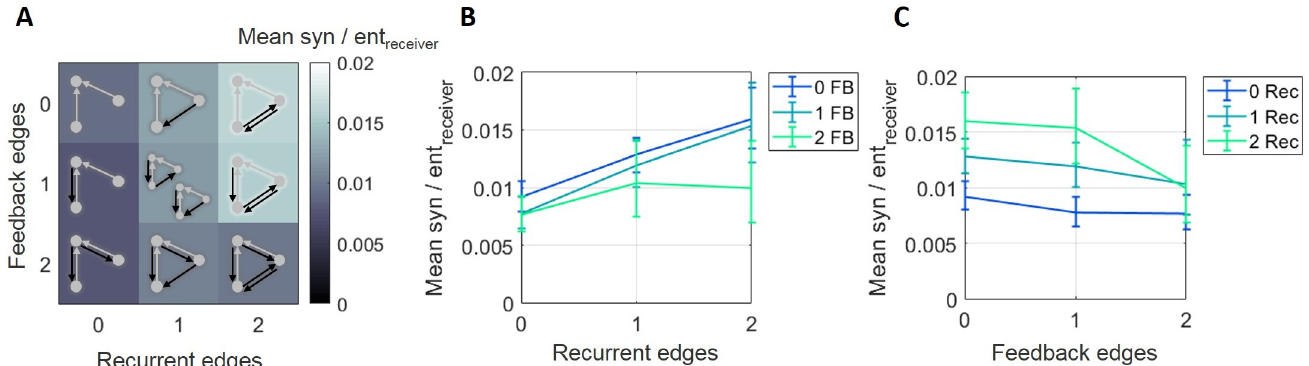
Fig 4. Normalized synergy increased with greater recurrence and decreased with greater feedback. (A) Motifs are ordered based on the number of recurrent edges (columns) and feedback edges (rows). The background heatmap, wherein brighter colors reflect larger normalized synergy values, replots the central tendency of the values shown in Fig 3. (B) Curves representing rows shown in A, plotted with errorbars computed across networks, show that synergy increased as the number of recurrent edges increased. (C) Curves representing columns shown in A, plotted with errorbars computed across networks, show that synergy decreased as the number of feedback edges increased. Errorbars are 95% bootstrap confidence intervals around the